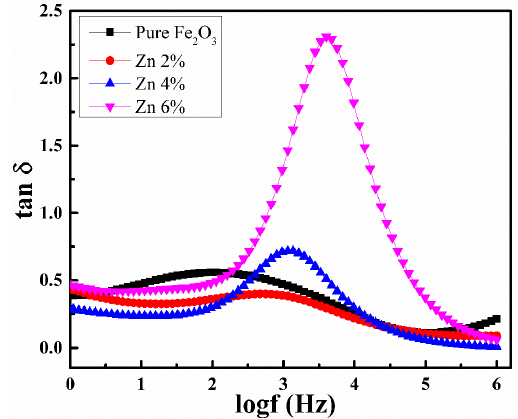
Figure 11. Variation of dielectric loss with frequency of pure Fe 2 O 3 , Zn 2%, Zn 4% and Zn 6% nanoparticles.